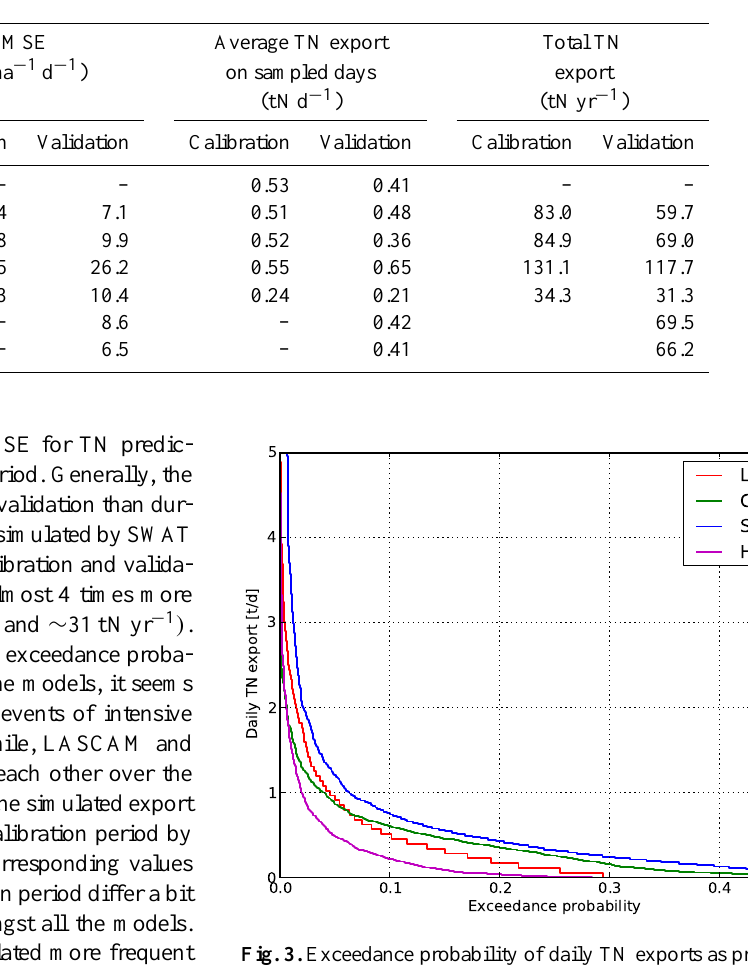
diminution of the TN export after a reduction in fertiliser application. The responses of LASCAM, SWAT and HBV- N-D to the changes in management practices are compara- ble to each other, with total reductions of less than 10 % when no fertiliser is applied. Conversely, CHIMP presents a totally different behaviour with a reduction of up to 80 % of its initially simulated TN export. The simple mean pro- vides intermediary predictions towards a ∼ 25 % TN export reduction with no fertiliser. Nevertheless, the REA average change is well in agreement with HBV-N-D, LASCAM and SWAT with a reduction in TN export below 10 %. The shaded area in Fig. 4 represents ∼ 60–70 % of the uncertainty (REA average ± RMSD) of the change and always includes these 3 models but not CHIMP. The simple averaging scheme is not in the uncertainty bounds of the REA for reductions of more than 30 % in fertilisation, and moves further away from it when the reduction